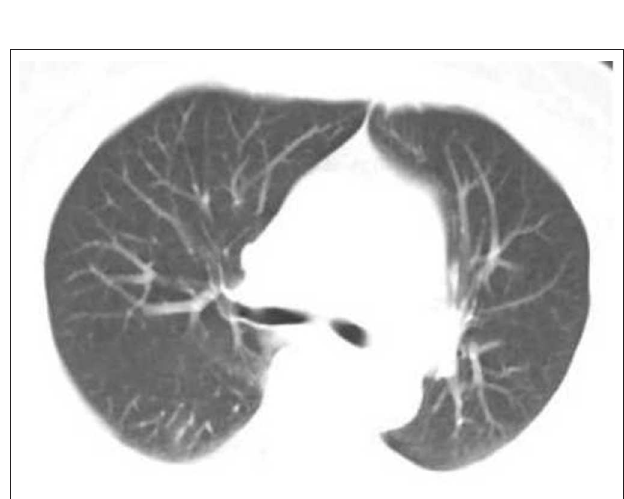
FIGURE 5 | Female, 56 years, with fever pending investigation. HRCT plain scan axial lung window showing lesions in bilateral lung lobes at the first time. The same patient was re-examined after 15 days, the patient was recovered after treatment, no lesions on her CT imaging.